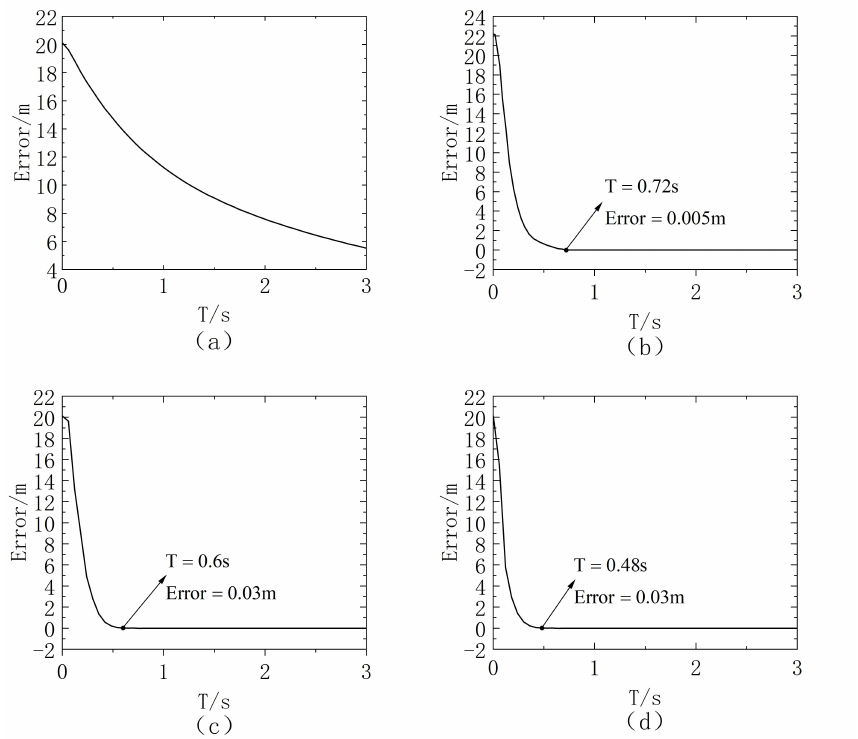
Figure 8. Drop point control error: ( a ) based on nonadaptive fuzzy controller considering constant horizontal wind disturbances; ( b ) based on nonadaptive fuzzy controller without considering wind disturbances; ( c ) based on adaptive fuzzy controller considering wind disturbances; ( d ) based on nonadaptive fuzzy controller considering wind disturbances.